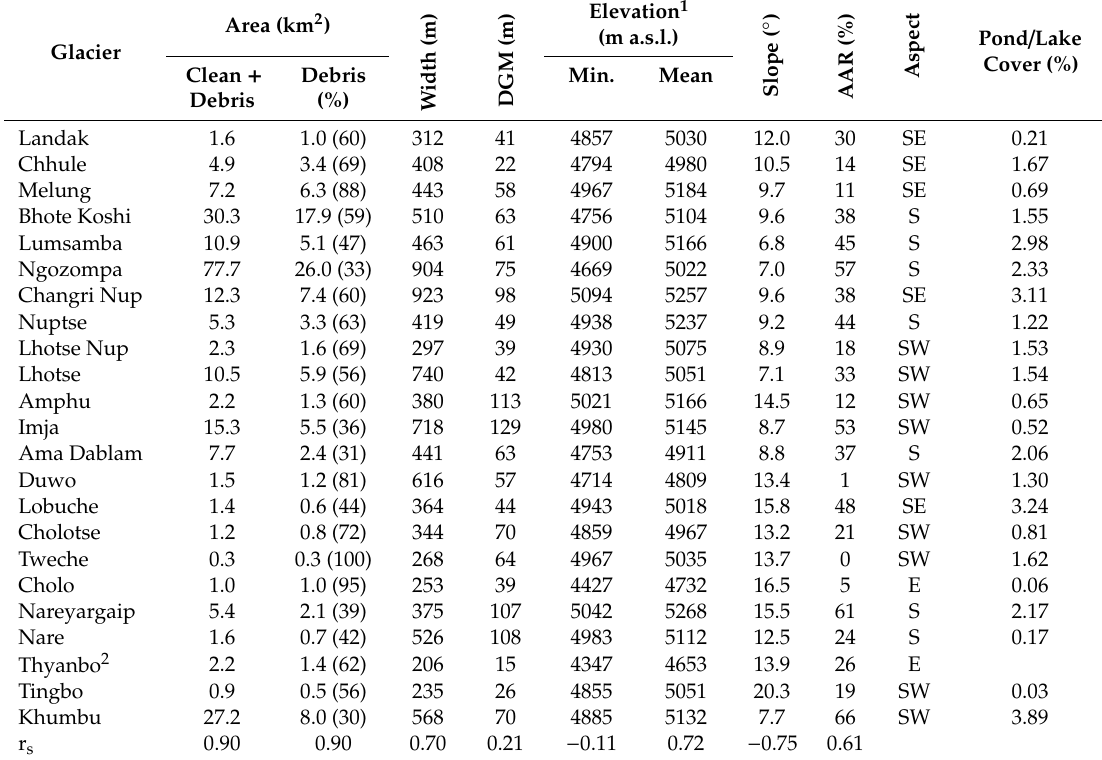
Table1. MorphometriccharacteristicsoftheglaciersandsupraglacialpondsandlakesoftheSagarmatha National Park in 2015 and